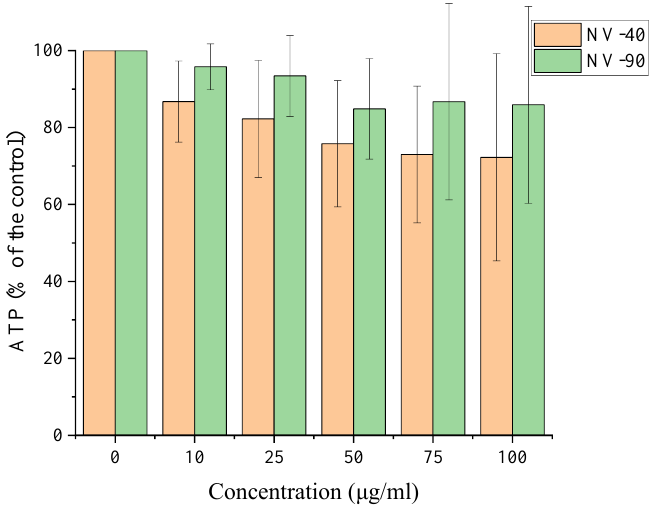
Figure 4. The effect of NV NDs on ATP production in MSCs. Cells were seeded at a density of 2 × 10 5 cells/well for 24 h and NDs were then incubated with MSCs for a further 24 h ahead of measuring ATP.